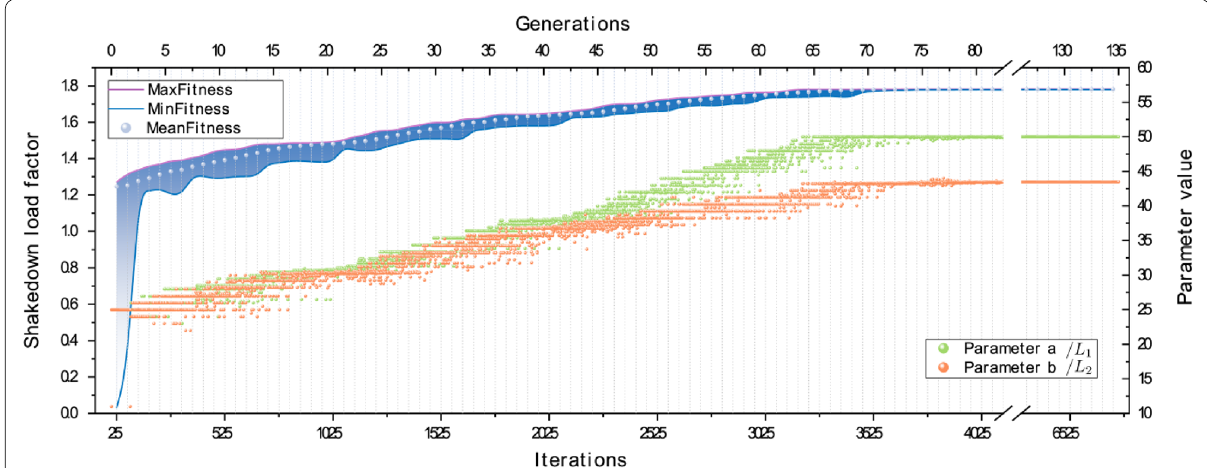
Figure 3 Convergence process of the present algorithm